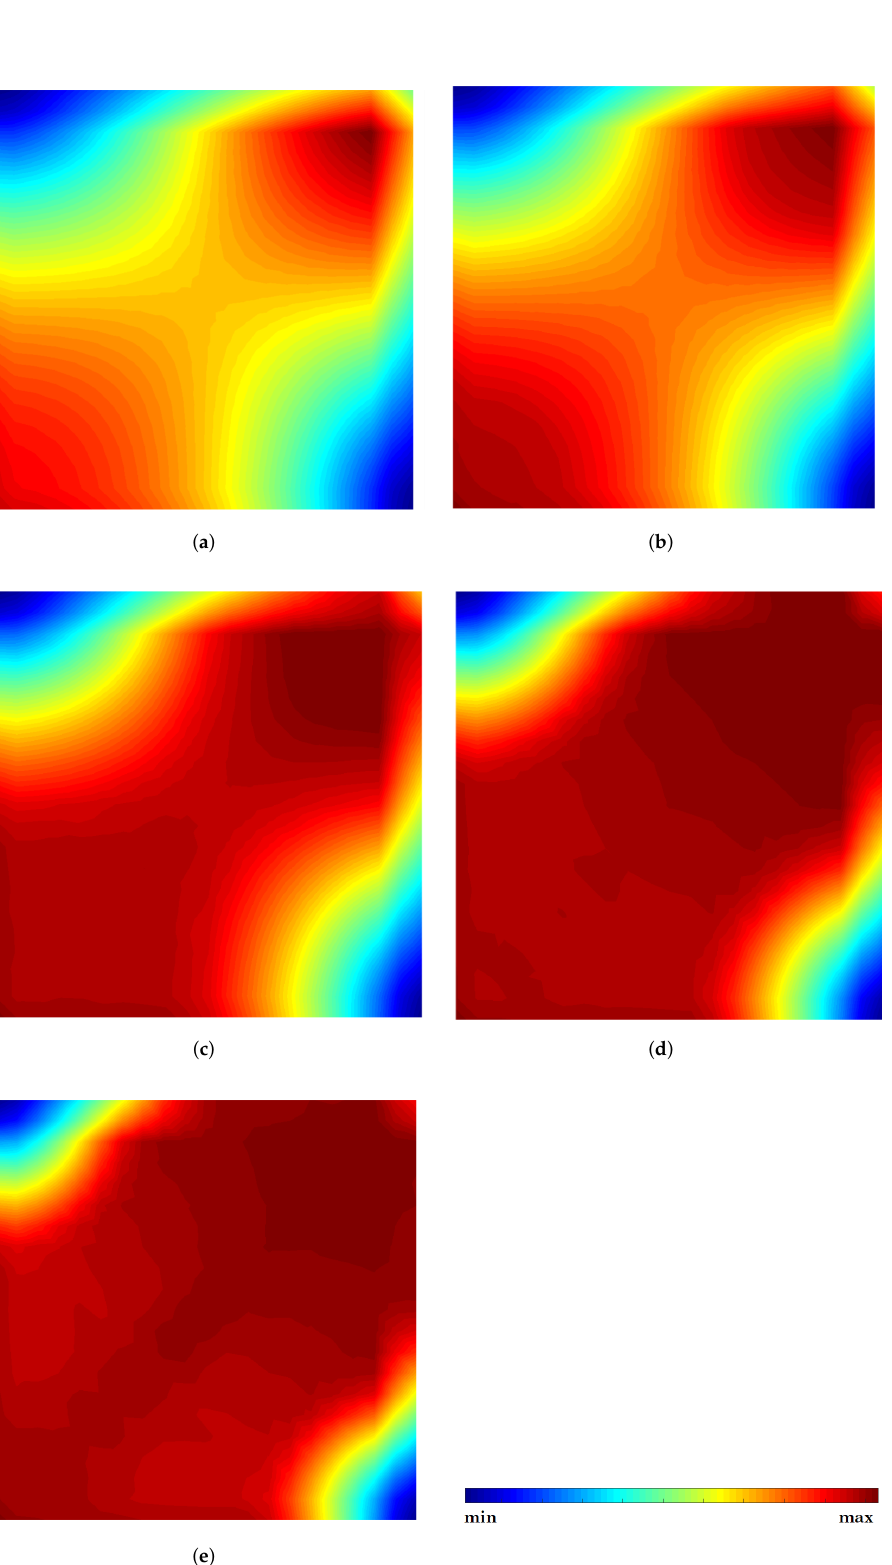
Figure 10. Effective von Mises stress distribution maps obtained with FEM for five load increments considering the simply supported plate. For each load increment, the minimum and maximum effective stresses are: ( a ) f = 814.89 KN/m 2 : σ min = 0 MPa; σ max = 170 MPa. ( b ) f = 998.25 KN/m 2 : σ min = 0 MPa; σ max = 205 MPa. ( c ) f = 1181.60 KN/m 2 : σ min = 0 MPa; σ max = 210 MPa. ( d ) f = 1364.95 KN/m 2 : σ min = 0 MPa; σ max = 215 MPa. ( e ) f = 1487.18 KN/m 2 : σ min = 0 MPa; σ max = 220